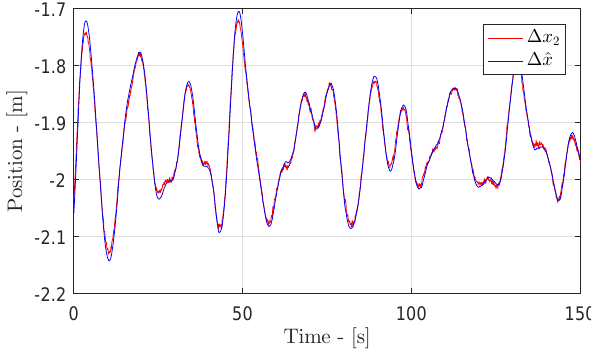
Figure 17: Sensor fusion performance in x-direction.